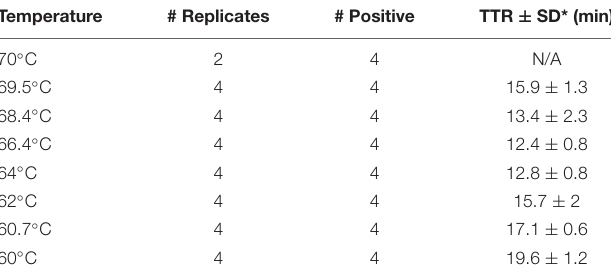
TABLE 4 | Time to result (mean of the TTRs of four replicates) at different temperatures. Temperature